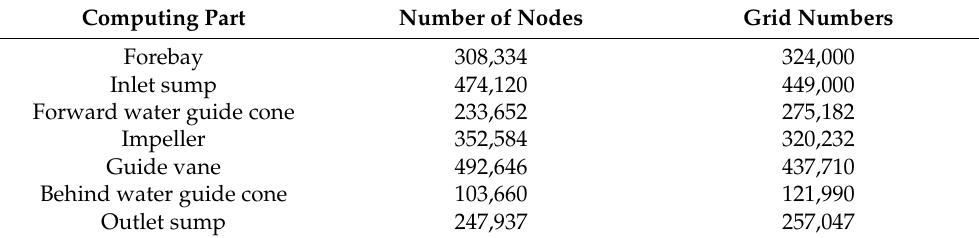
Table 1. The number of grids and nodes in each computing part.